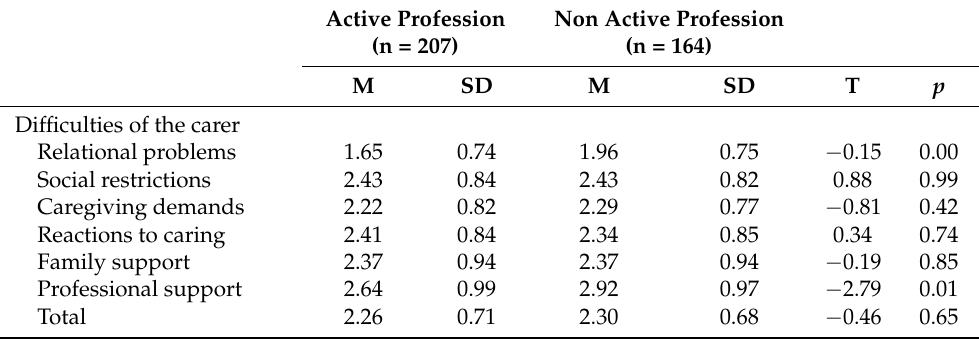
Table 7. Results of the study of caregiver difficulties as a function of professional activity (ac- tive/not